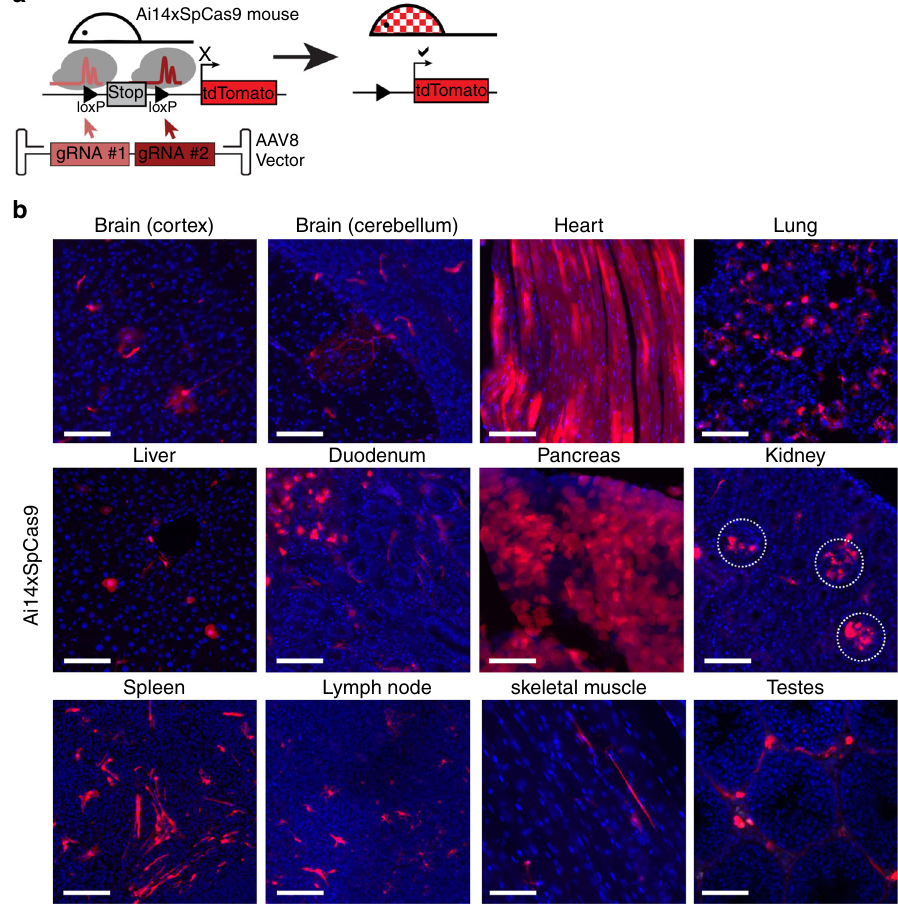
Fig. 6 Ai14xSpcas9 mice capture AAV8-CRISPR-Cas9 editing across tissues. a AAV8-ROSA-gRNAs vector edits the ROSA26 locus and activates tdTomato expression in Ai14xSpCas9 mice. b Representative photomicrographs of tissue from Ai14xSpCas9 mice at 2 weeks post IV delivery of 2.3e11 vg AAV8- ROSA-gRNAs per mouse. tdTomato expression (red) and nuclei (blue) are shown. n = 3 Ai14xSpCas9 mice. Scale bars = 100 µ